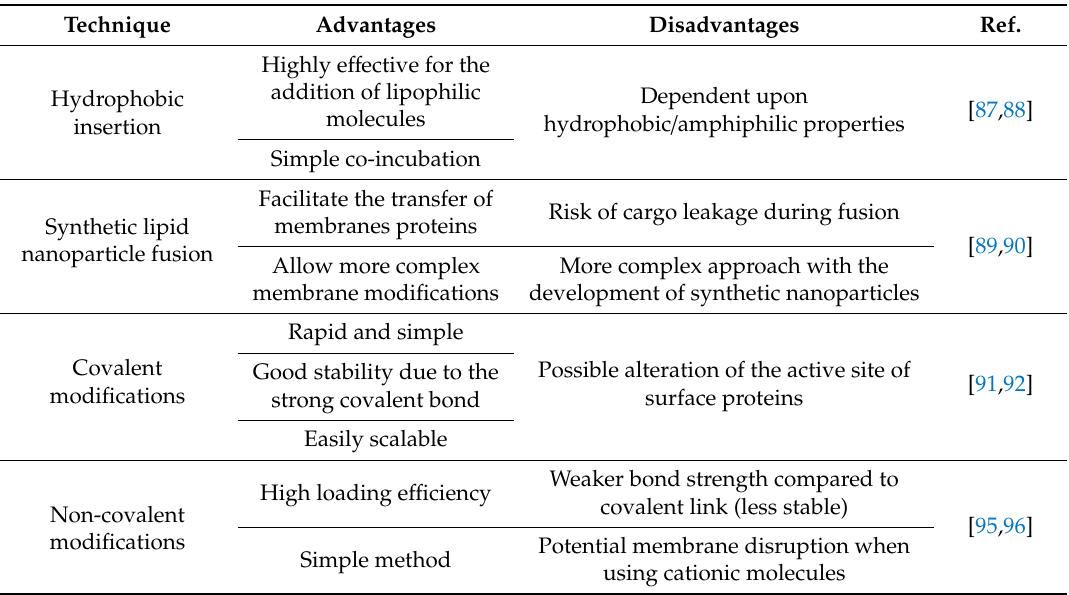
Table 3. EV surface modification